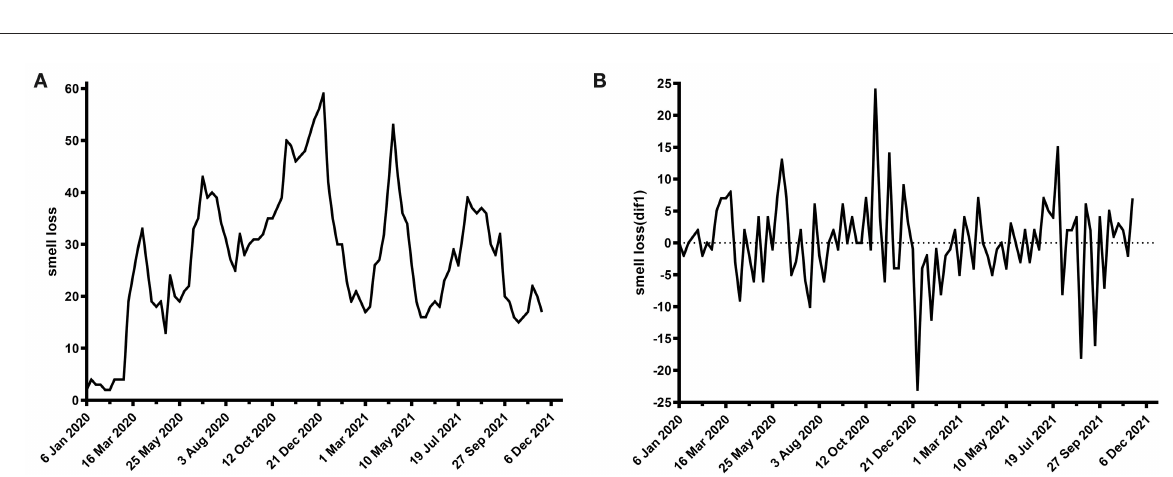
‹ Significance test of